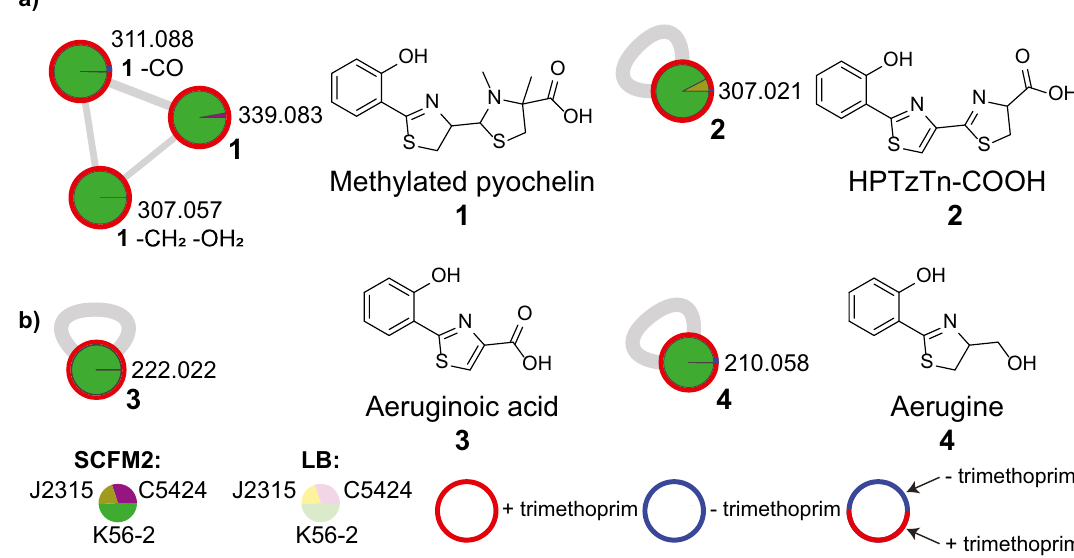
Figure 3. Analysis of pyochelin biosynthetic metabolite production across three B. cenocepacia strains. Pie charts within nodes correspond to relative abundance in each strain obtained via integration of area under the chromatographic peak (green: K56-2, purple: C5424, brown: J2315) and media condition (darker shade for SCFM2 and lighter shade for LB). The coloring of node border represents whether the metabolite was detected only in the presence of trimethoprim (red border), only in the absence of trimethoprim (blue), or both in the presence or absence of trimethoprim (mixed color). A combination of blue and red border color shows total relative abundance of the metabolite in the absence or presence of trimethoprim, respectively across all strains. The production of these compounds was only detected in SCFM2 medium, and in the presence of the antibiotic trimethoprim. ( a ) Annotated structural analogs of pyochelin, including methylated pyochelin ( 1 ) and HPTzTn-COOH ( 2 ). ( b ) Annotated shunt products of pyochelin biosynthesis, including aeruginoic acid ( 3 ) and aerugine ( 4